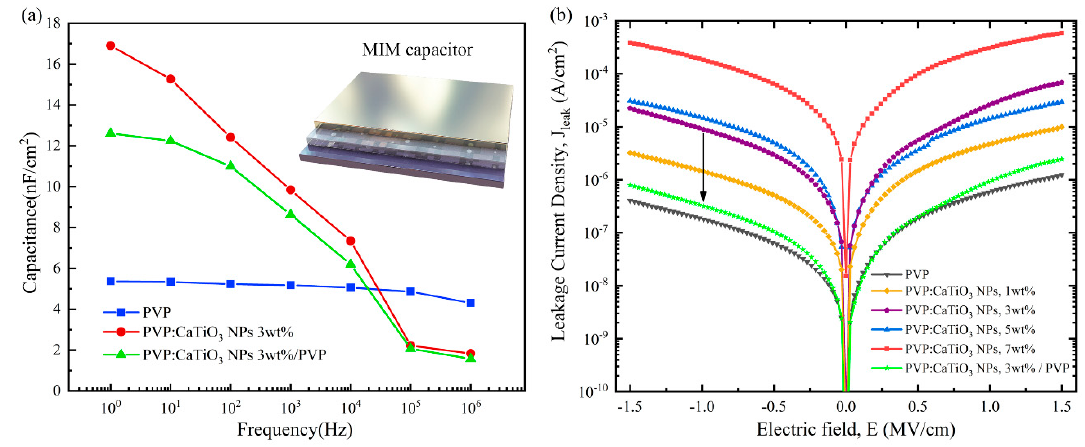
Figure 2. ( a ) Comparison of the frequency-dependent areal capacitance of di ff erent dielectric films; ( b ) Leakage current density − electric field characteristics of dielectrics as a function of the CaTiO 3 nanoparticles (NPs) ratio.